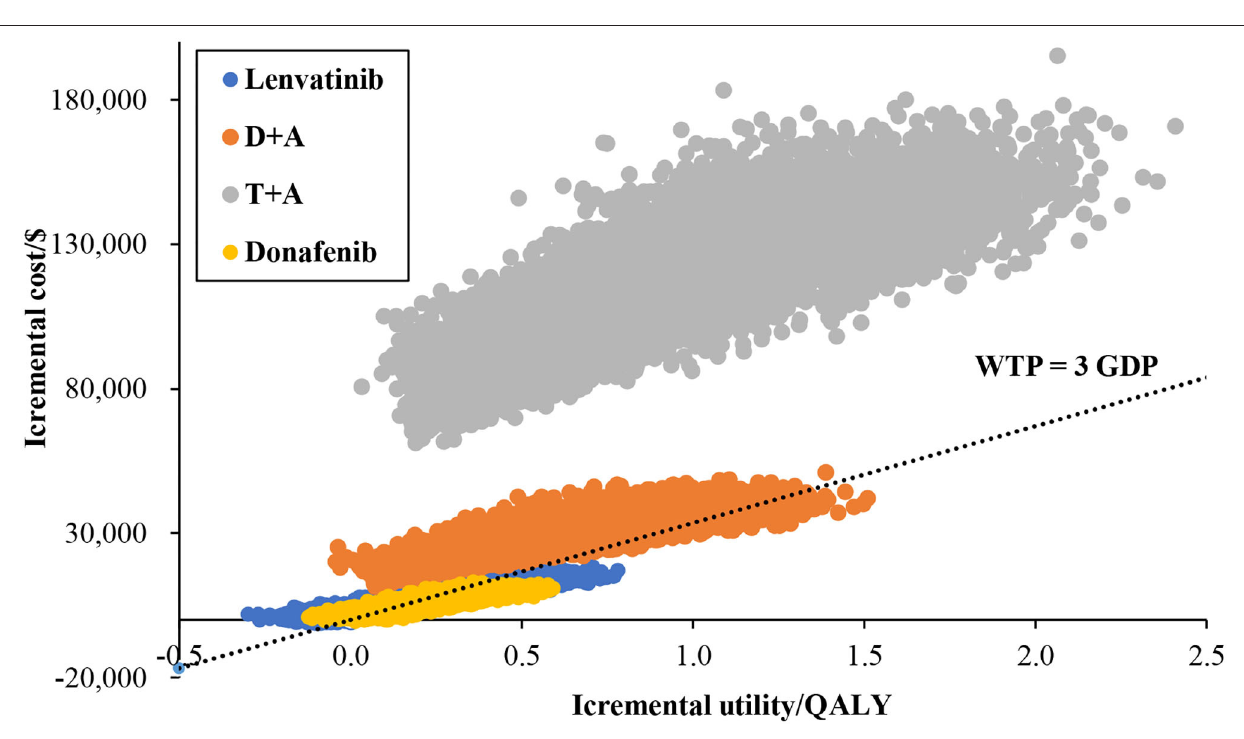
FIGURE 3 | Base-case probabilistic sensitivity analysis: scatter plot (10,000